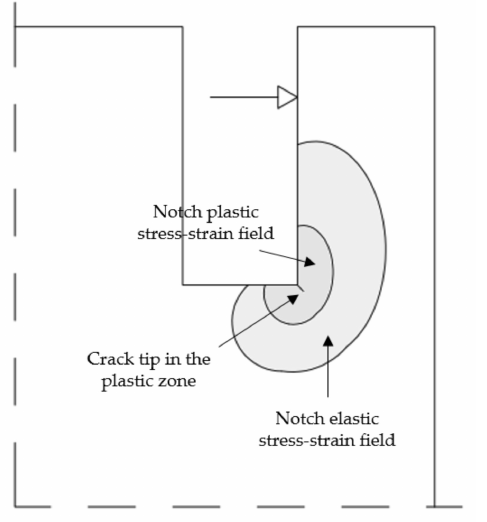
Figure 3. Phenomenology of crack growth through a notch stress–strain